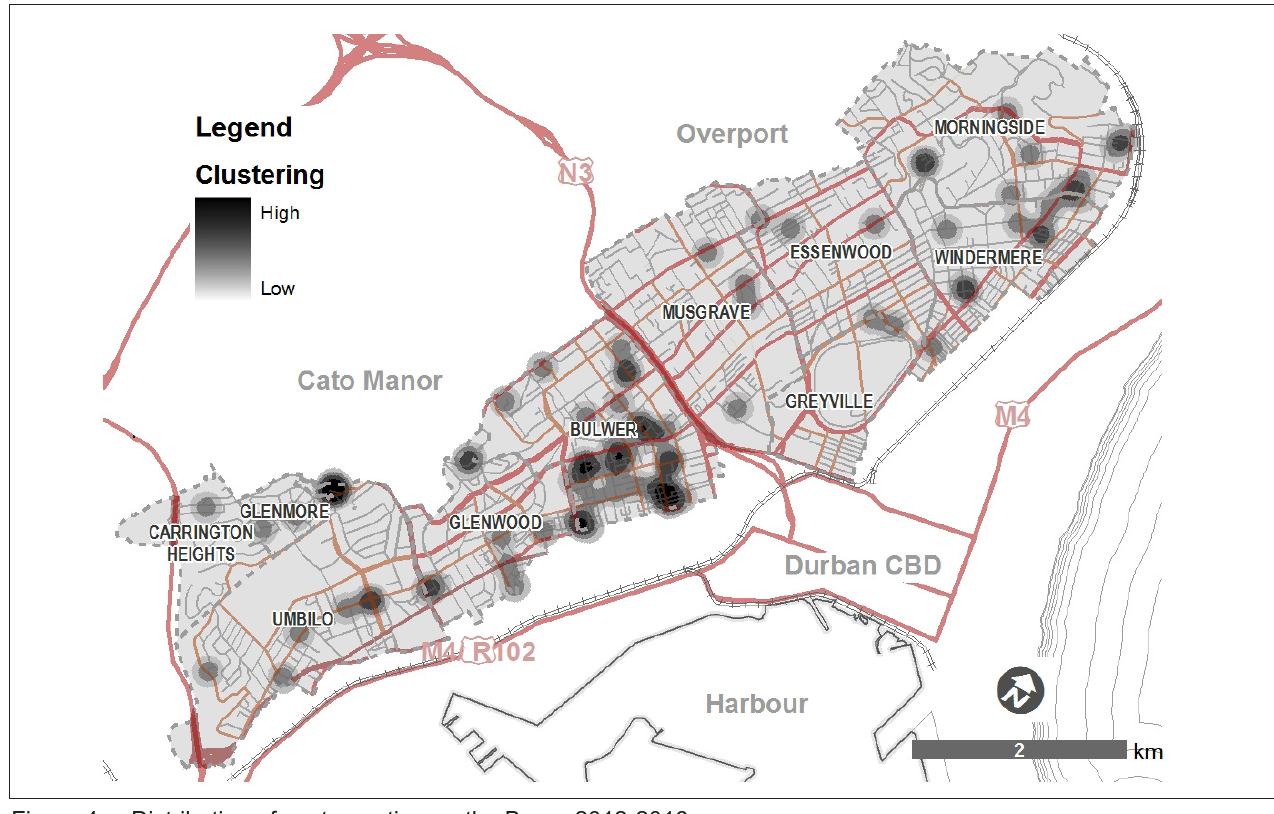
Figure 4: Distribution of contravention on the Berea 2012-2016 Source: Adapted from eThekwini Municipality Central Durban Application Register by DUT GIS Unit,